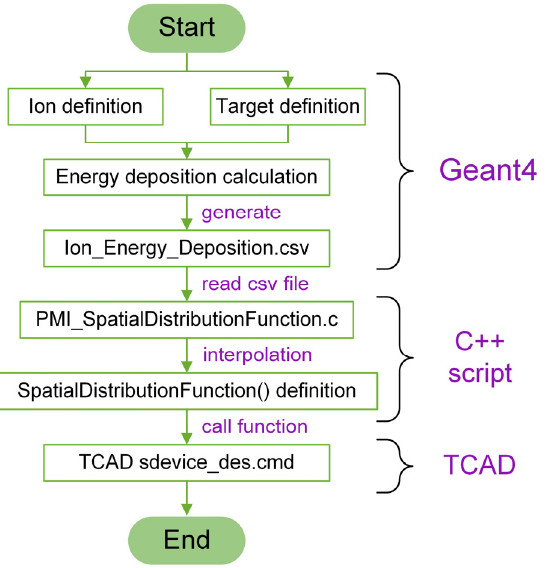
Figure 8. The workflow for introducing the EHPs’ distribution generated by the Geant4 calculation to the TCAD simulation.